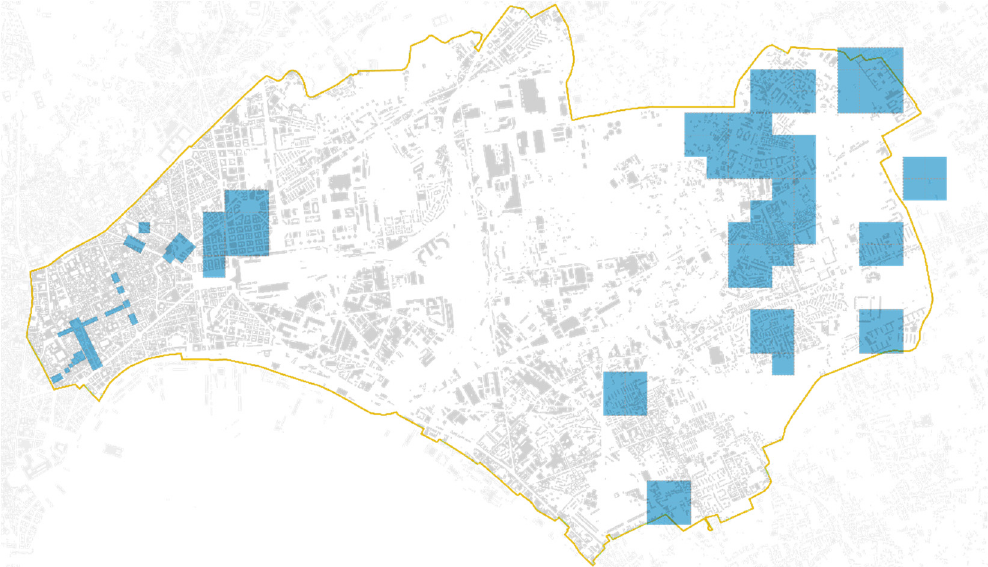
Figure 4. The perimeter of chosen areas for microclimatic analysis.